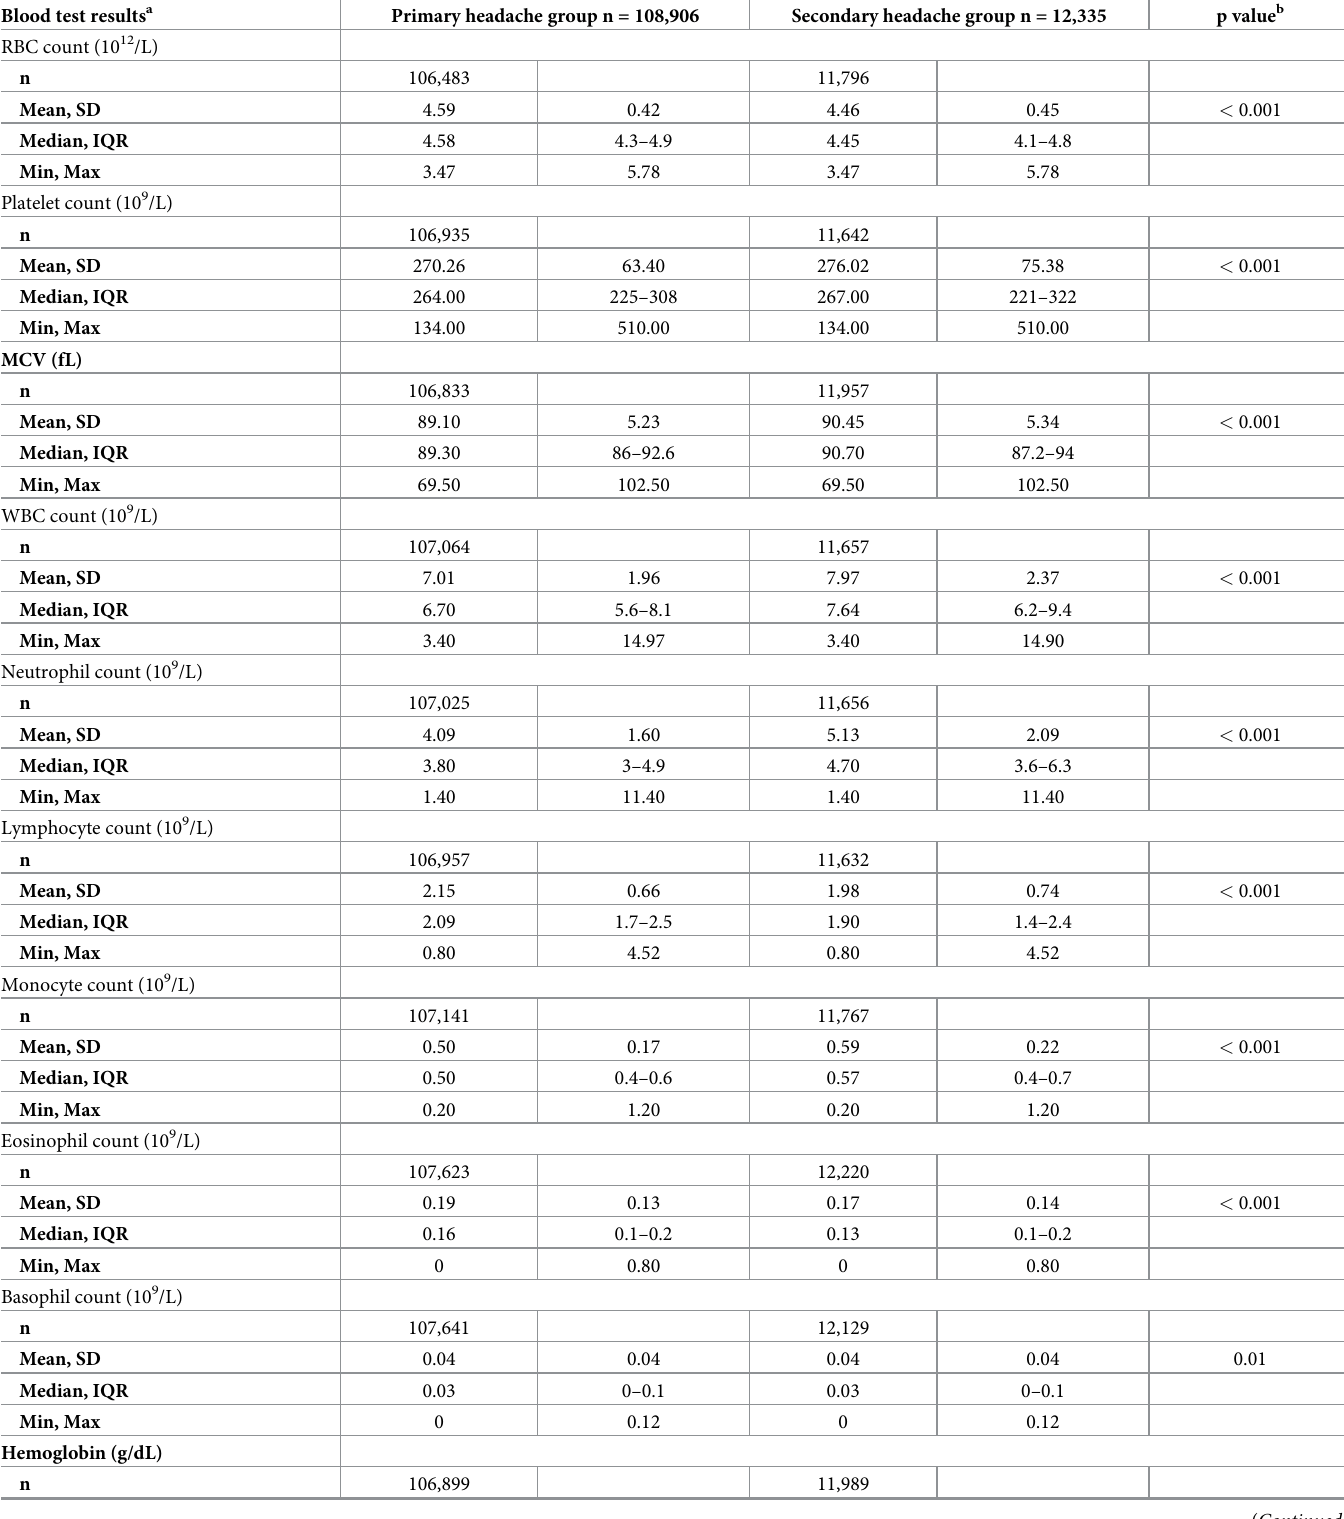
Table 2. Descriptive statistics for variables from the CBC test for the analytical cohort (n =